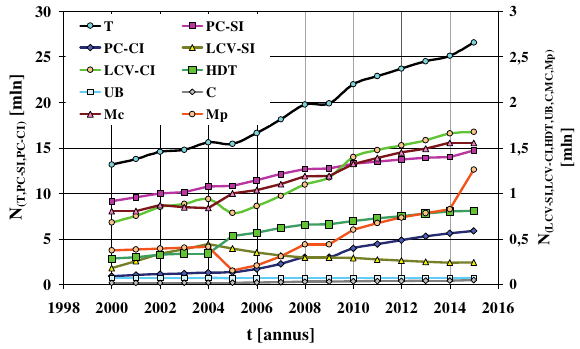
Fig. 1. Number of vehicles per cumulated category